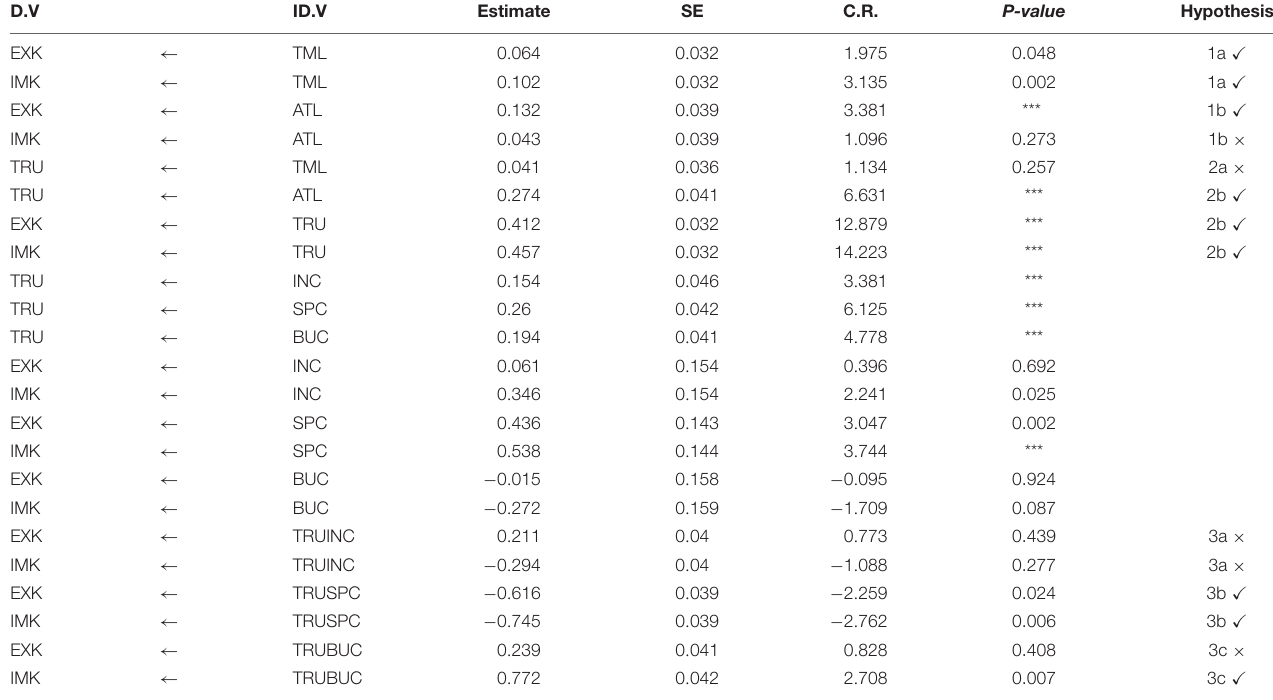
TABLE 4 | Structural equation analysis